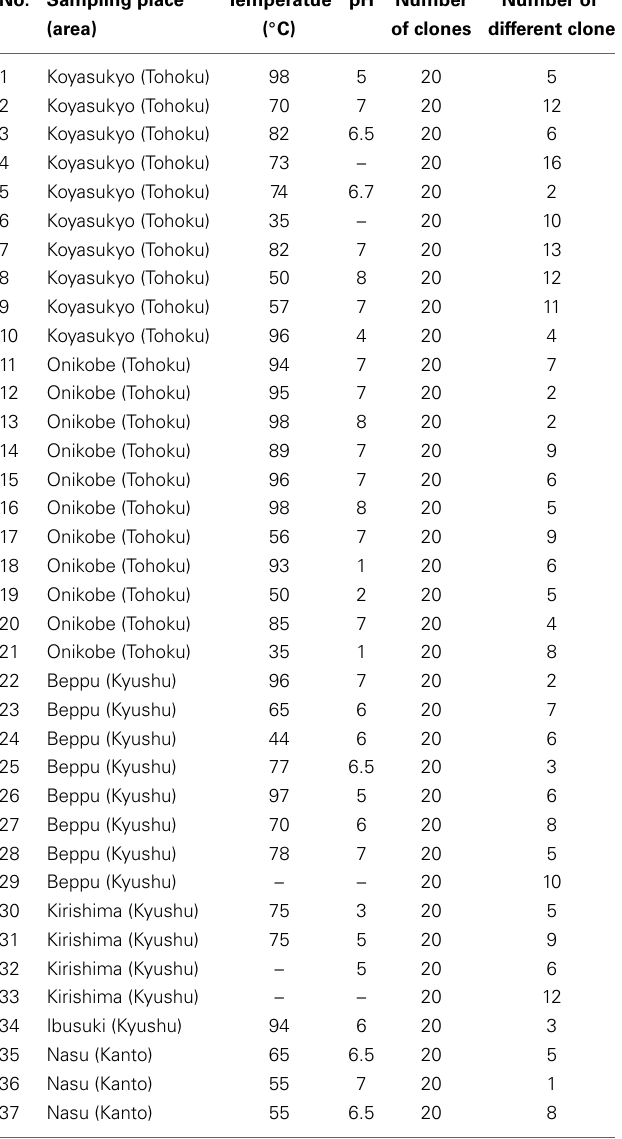
Table 2 | Summary of metagenomic